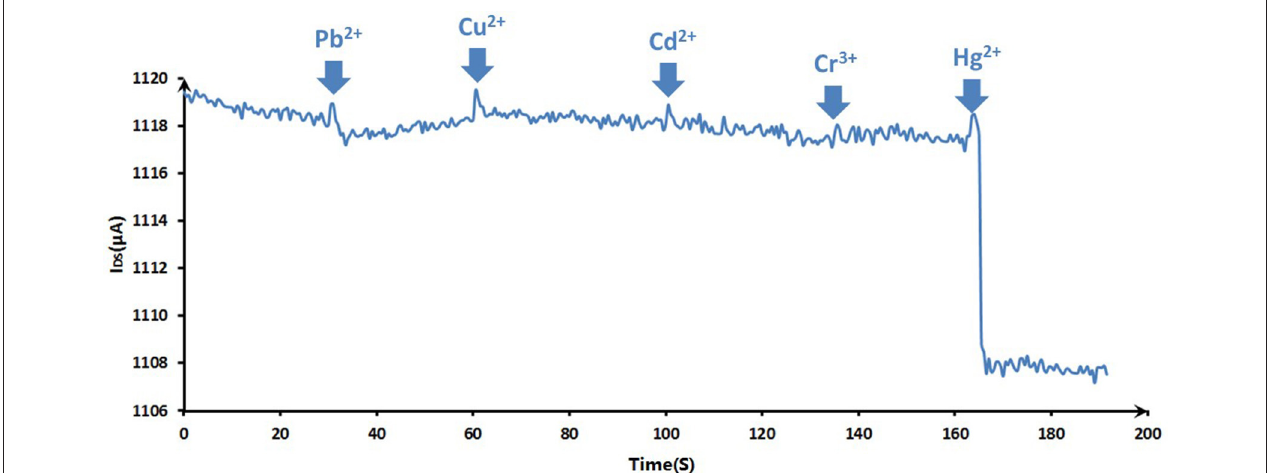
FIGURE 9 | The selective responses of the DNA-based biosensor to various metal ions: Cu 2 + , Pb 2 + , Cr 3 + , Cd 2 + (10nM for previous ions) and Hg 2 + (100pM). The arrows pointed the adding time for corresponding ions.